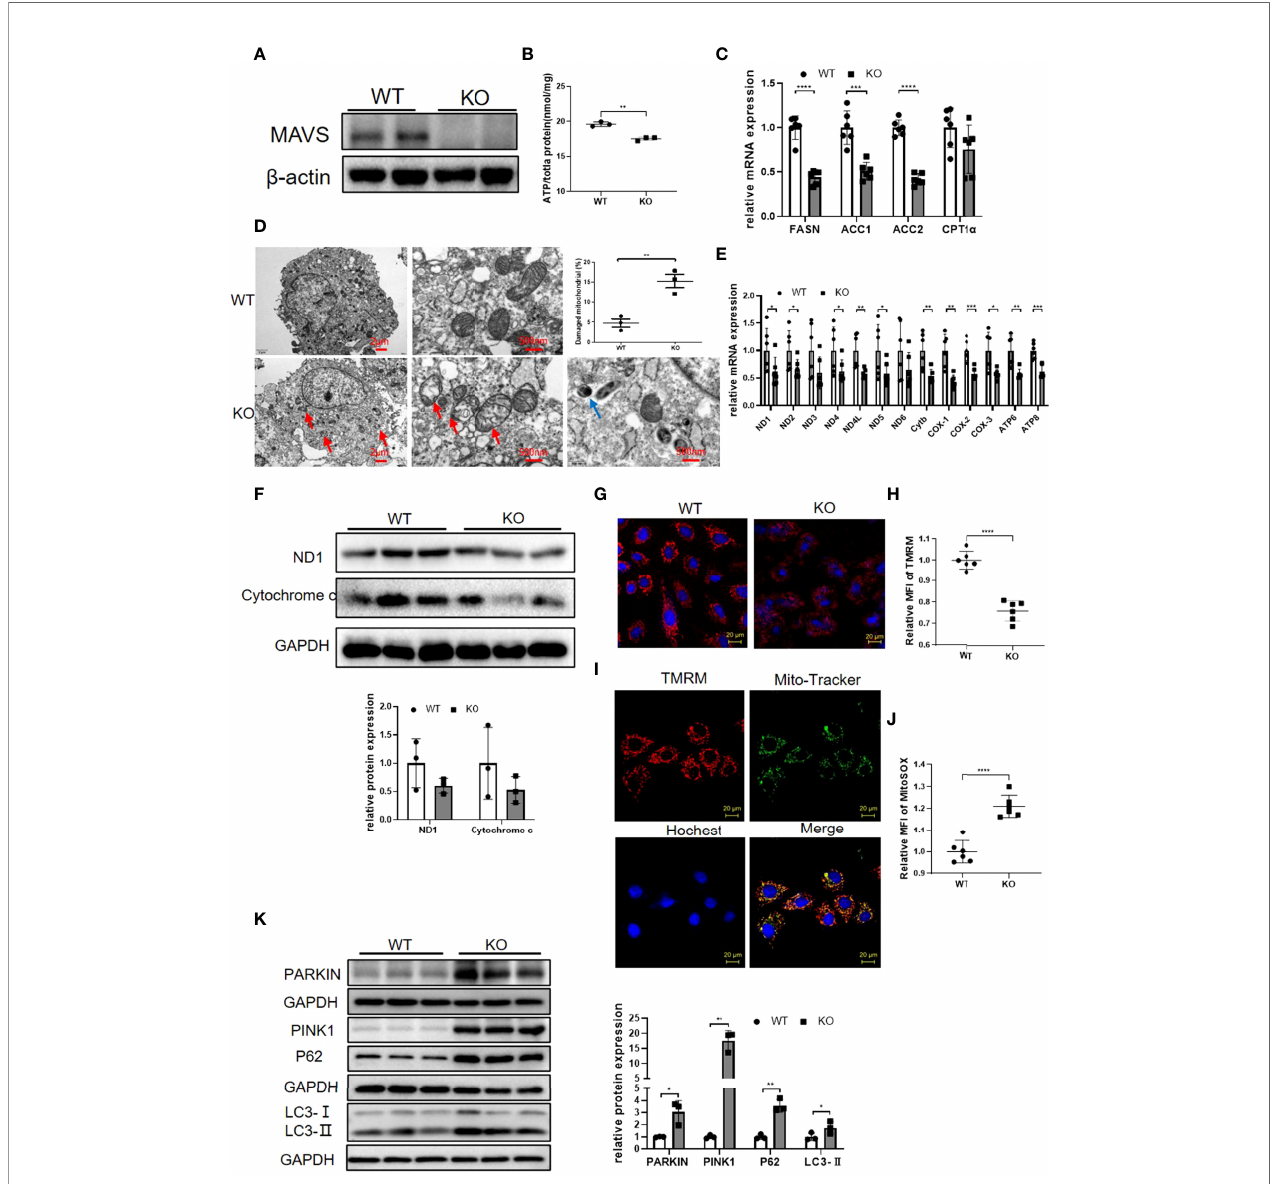
FIGURE 5 | Loss of MAVS resulted in mitochondrial dysfunction in H9C2 cells. (A) . Representative western blotting veri fi ed the deletion of MAVS by CRISPR/Cas9 in H9C2 cells. (B) . ATP production was reduced in H9C2-/- cells. (C) . RT-qPCR analysis of some genes (FASN, ACC1, ACC2, CPT1 a ) involved in lipid metabolism in H9C2-/- cells (n=6) (D) . Representative TEM images of damaged mitochondria and autophagosomes in H9C2-/- cells, (Left panel, scale bar: 2 µm; Right panel, scale bar: 500 nm; red arrow: damaged mitochondria; blue arrow: autophagosomes). Quanti fi cation of damaged mitochondria in H9C2-/- cells by TEM images (n=3). (E) . RT-qPCR analysis for mitochondrial genes in control and H9C2-/- cells (n=6). (F) . Western blotting analysis of mitochondrial electron transfer chain proteins ND1 and Cytochrome C in H9C2-/- cells. Densitometry analysis of the western blots of ND1 and Cytochrome C (n=3). (G) . Representative fl uorescence images of tetramethylrhodamine, methyl ester (TMRM) in H9C2-/- cells (original magni fi cation, 400×; scale bar: 20 µm). (H) , Quantitative analysis of MFI of TMRM by fl ow cytometry (n=6). (I) . Representative fl uorescence images from confocal microscope con fi rmed the staining signals of MMP was from mitochondria. TMRM (red); Mito-tracker staining (green); Hoechst (blue); merge image (yellow) (original magni fi cation, 400×; scale bar: 20 µm). (J) . Quantitative analysis of MFI of MitoSOX by fl ow cytometry in H9C2 cells (n=6). (K) . Western blotting analysis of mitophagy marker proteins Parkin, PINK1, LC3-II, and P62. Densitometry analysis of the western blots of above proteins (n=3). The quantitative results are shown as the means ± SEM (*P < 0.05, **P < 0.01, ***P<0.001 and ****P <